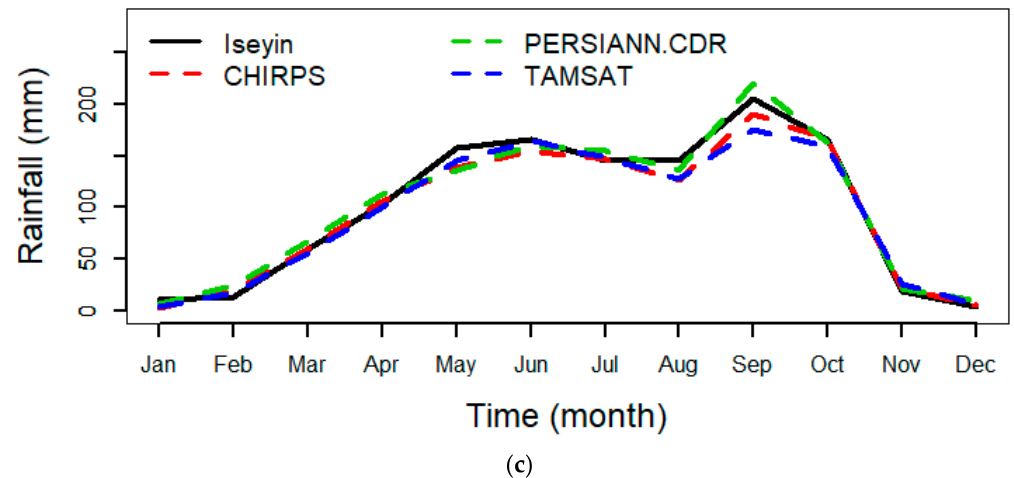
Figure 3. Annual cycle of rainfall amount (mm) for ( a ) Nguru, ( b ) Jos, and ( c ) Iseyin, located in the Figure 3. ( a ) Mean Monthly Rainfall Data at Nguru Climatic Station in the Sahel Zone; ( b ) Mean Sahel, Savannah and Guinea Coast climatic zones, respectively. Monthly Rainfall Data at Jos Climatic Station in the Savannah Zone; ( c ) Mean Monthly Rainfall Data at Iseyin Climatic Station in the Guinea Coast Zone. Table 3. Root mean square error (RMSE) values (in mm) for all products with respect to gauged datasets. Table 3. Root mean square error ( RMSE) values (in mm) for all products with respect to gauged datasets.